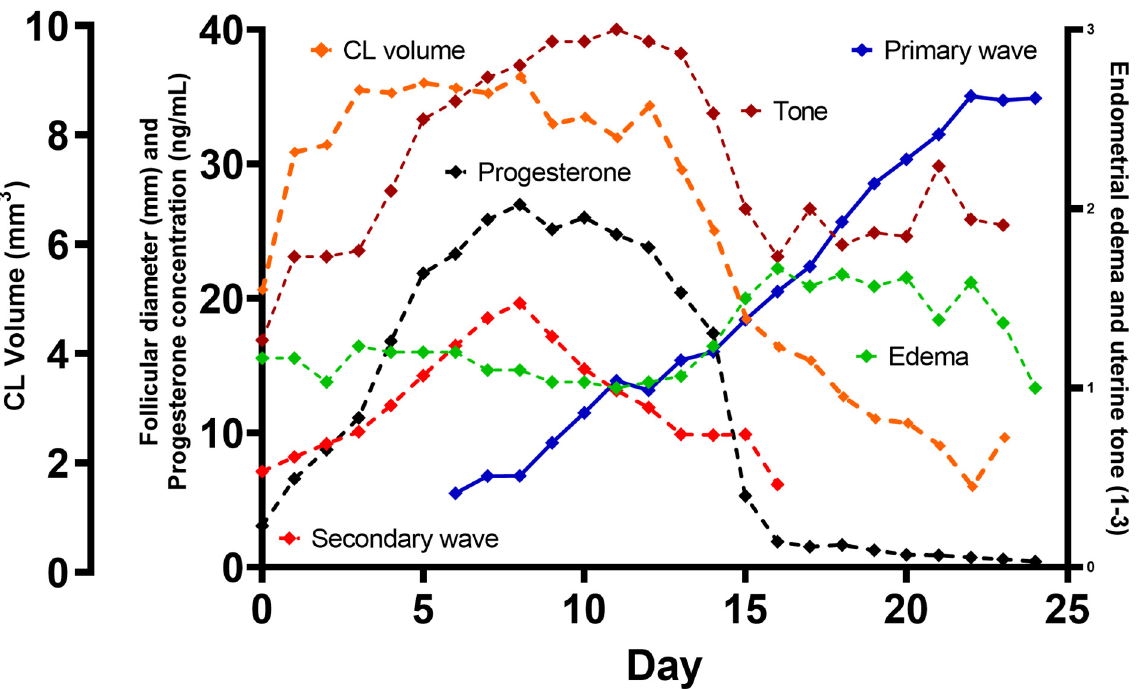
Figure 3. Mean temporal relationships among the diameter of the dominant follicle in the primary and secondary follicular waves, CL volume, progesterone concentrations, and mean scores of the uterine tones and endometrial edema during four estrous cycles of eight Caribbean jennies (n = 31) under tropical conditions. Day 0, day of ovulation.